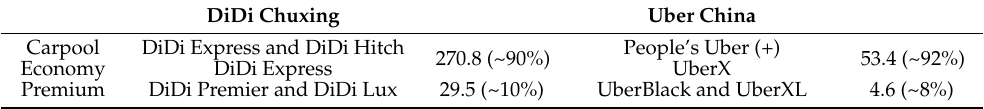
Table 3. Daily order requests (in millions) per service offering